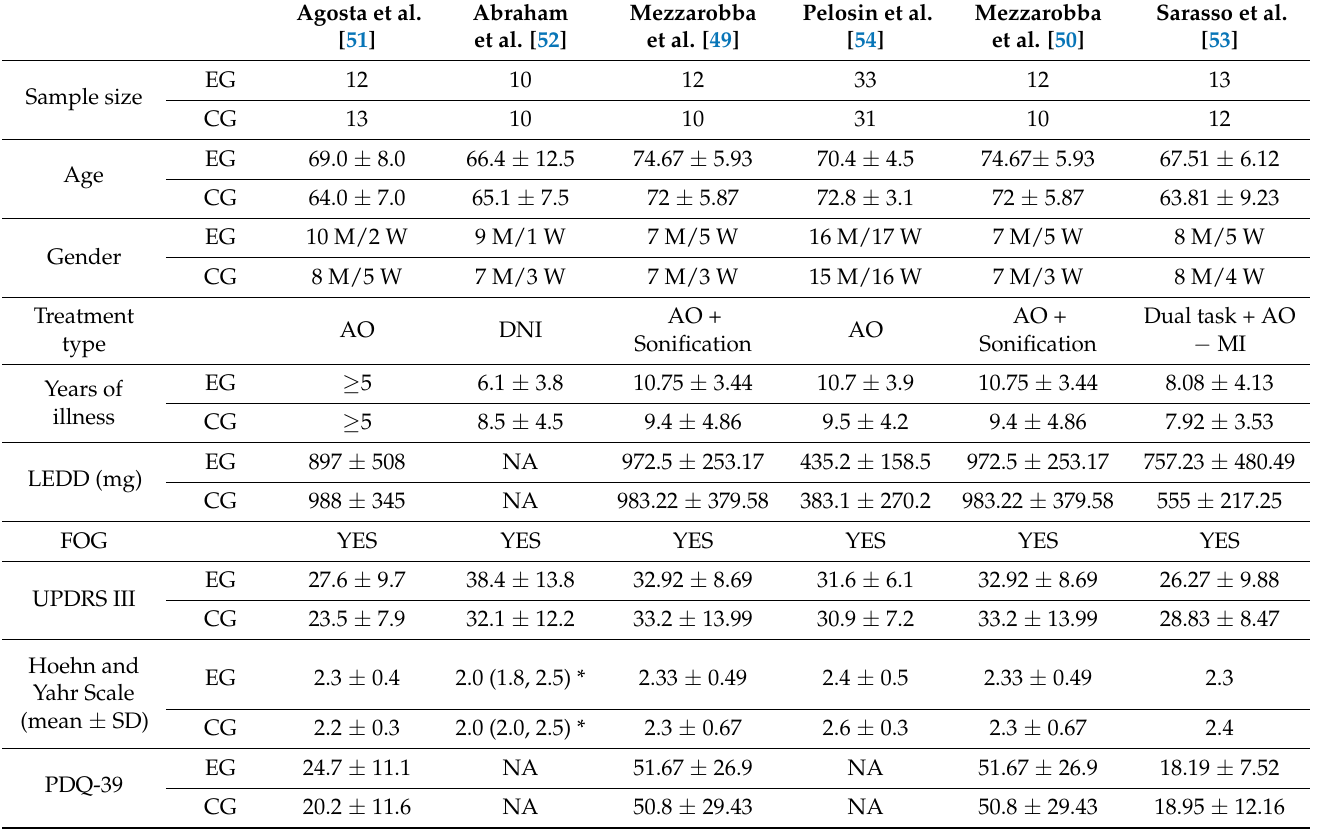
Table 1. Table 1. Socio-demographic and clinical variables